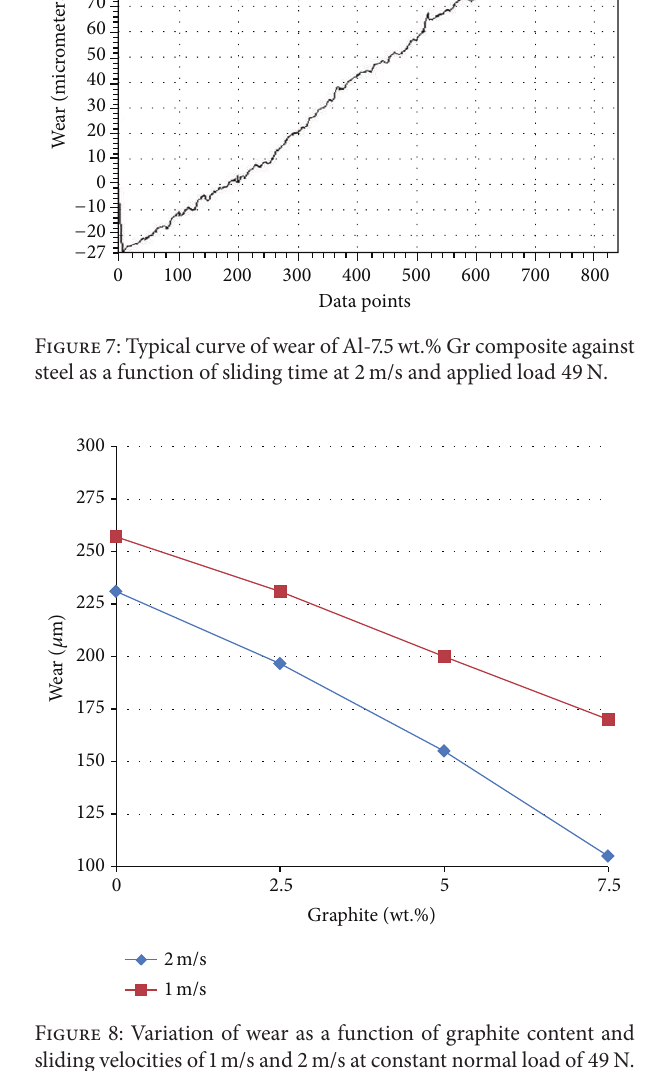
with 7.5 wt.% graphite content. It exhibits wear